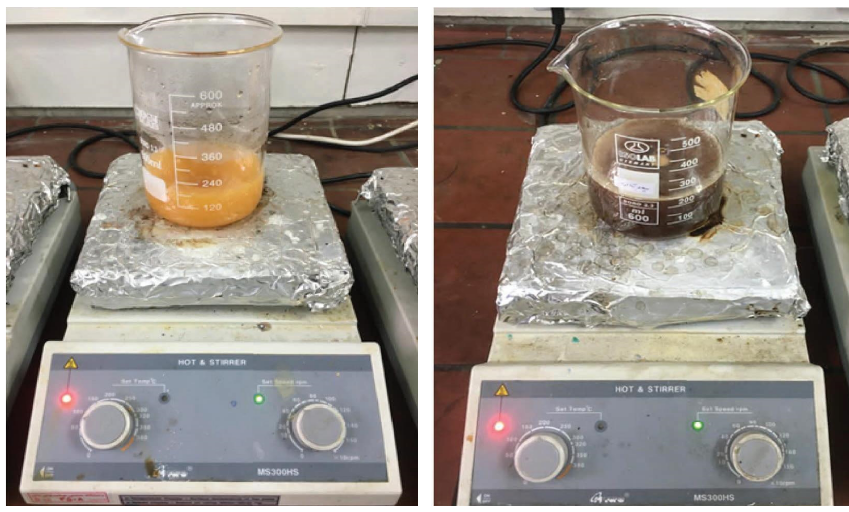
Figure 1: Adding the hydrogen peroxide solution to the inlet and outlet